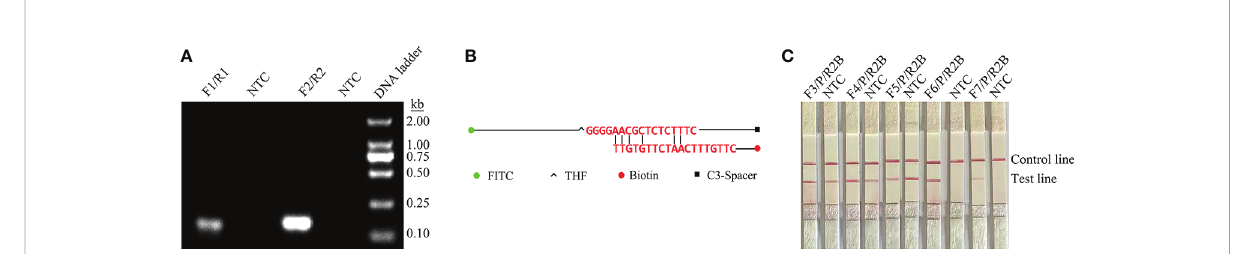
FIGURE 1 Screening of primer – probe combinations. (A) RPA results for two different primer sets of the ITS2 gene. The name of each primer group is shown at the top of each lane. NTC indicates the no-template control for the corresponding primer pair. All reactions were performed at 37°C for 20 min. These images represent the results of three independent experiments. (B) Pairwise analysis and sequence modi fi cation of the primer – probe set were used to detect the ITS2 gene using Primer Premier 5 software, and the associated DNA base substitutions for the probes and primers. The DNA strands are shown as horizontal lines and the matching bases are shown as vertical lines. Molecular markers are listed below in Figure (B) . (C) RPA-LFS assays for the validity of primer – probe sets. The name of each primer set is shown at the top of each lane. NTC denotes no-template control for the corresponding primer pair. The positions of the test and control lines are shown on the right. All reactions were performed at 37°C for 20 min. These images represent the results of three independent